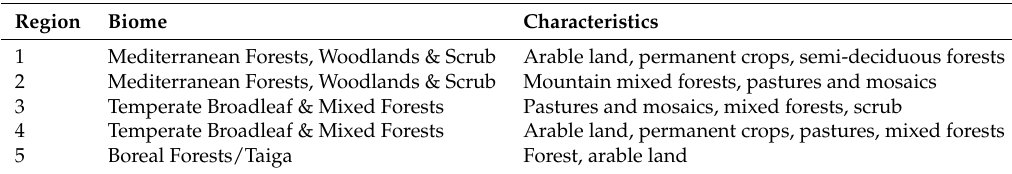
Figure 1. The map displays the geographical location of the five regions across Europe’s major biomes. These biomes include the mediterranean, temperate, and boreal from south–north and east–west. The boxes illustrate the selected regions at 1 × 1 ◦ spatial resolution and their subregions (with a size of 0.5 ◦ ). Table 1. List of the five study regions, with the specific biomes (after [35]) and characteristic land cover types. The predominant land cover types are classified according to the CORINE land cover (here, CLC2012; Version 18) by the European Environment Agency (EEA) Copernicus program [36] and are listed in decreasing order of